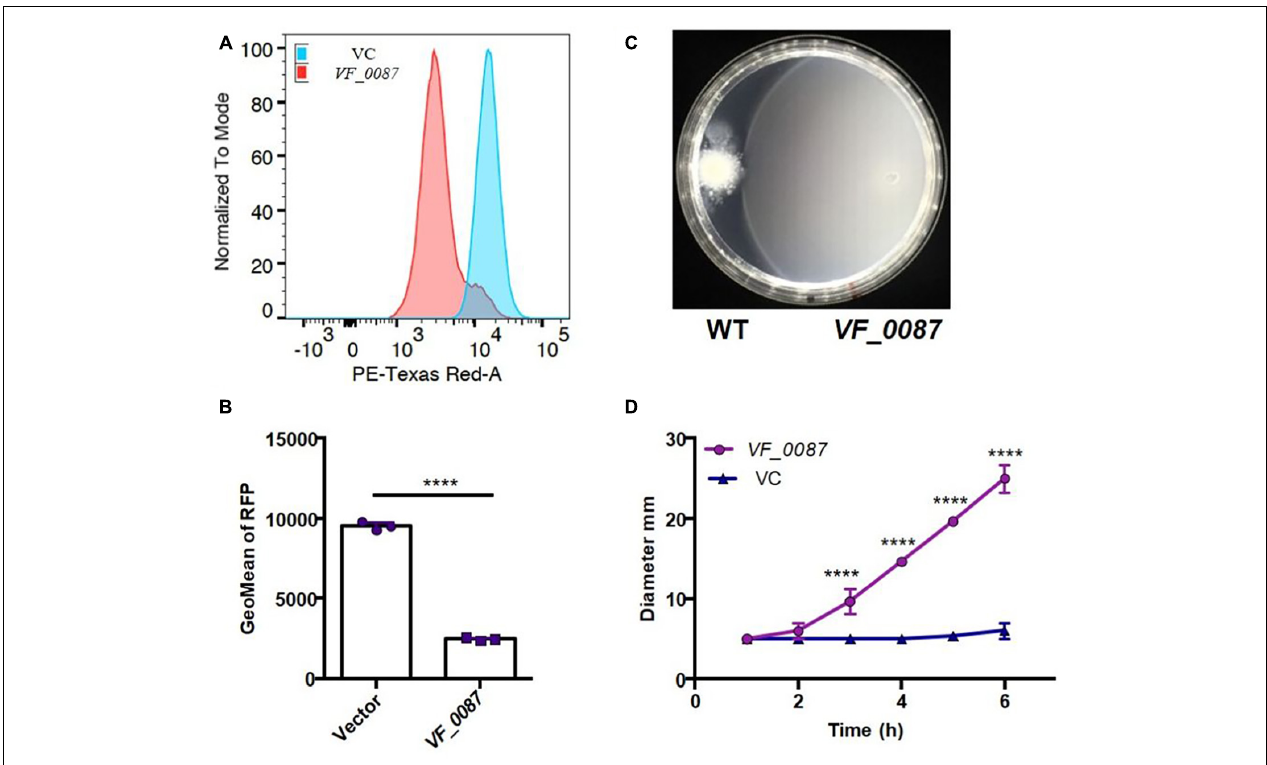
FIGURE 9 | Motility of KB2B1 is increased with decreased c-di-GMP. (A,B) Derivatives of KB2B1 carrying pFY4535 (see Figure 8A ), and either vector control plasmid pKV69 or PDE VF_0087 expression plasmid pKV302 was analyzed for red fluorescent protein (RFP) levels relative to constitutive AmCyan signal, as normalized to mode (A) and GeoMean of RFP (B) . (C,D) Migration of KB2B1 containing pKV69 [wild type (WT)] or the VF_0087 -overexpression plasmid pKV302 ( VF_0087 ) on TBS-Mg 2 + soft agar. (C) Captured at 12 h. Statistics in panel (B) were performed using an unpaired t -test with equal SD, and statistics in panel (C) were done using a two-way ANOVA. **** p <